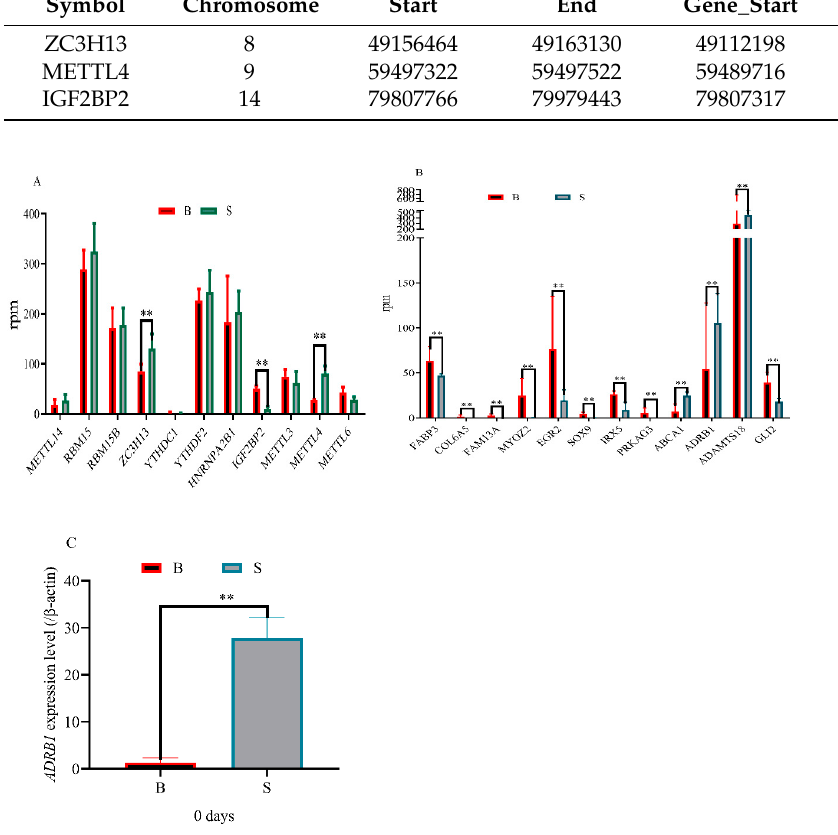
Figure 6. Overview of differentially expressed of methylase genes and key genes in muscle and adipose tissues samples (A) RPM of the methylase genes in muscle and adipose tissues; (B) RPM of the key genes in muscle and adipose tissues; (C) Expression level of ADRB1 gene in muscle and adipose tissues ( P < 0.01 ).(‘B’ refers to the longest dorsal muscle and ‘S’ refers to perirenal fat) ( “ ** ” , P ≤ 0.01). Table 4. Difference analysis of fat related genes between muscle and fat tissues.